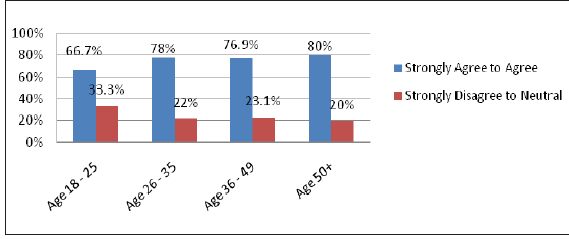
FIGURE 6 Internet banking is more convenient than traditional forms of banking - per age group